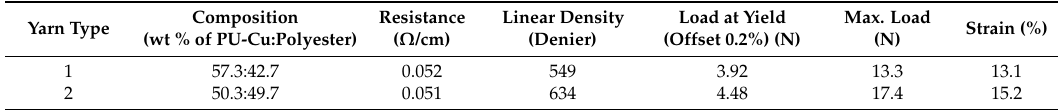
Table 2. Characteristics of the metal composite embroidery yarn (MCEY).